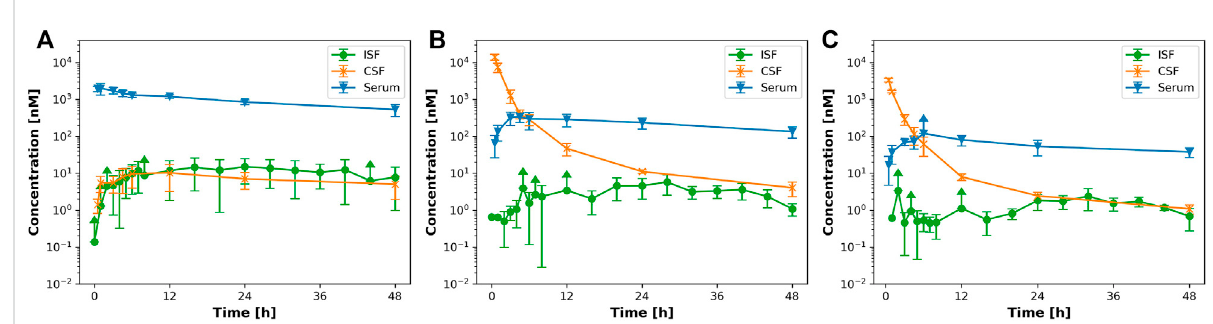
FIGURE 1 IVversusICVdosingforEGFRvIII-TCB.Figure1showsthePKpro fi leafter (A) 15 mg/kgiv; (B) 3 mg/kgICVand (C) 1 mg/kgicvofEGFRvIII-TCBin serum (blue), ISFbrain (green) and CSF (orange).